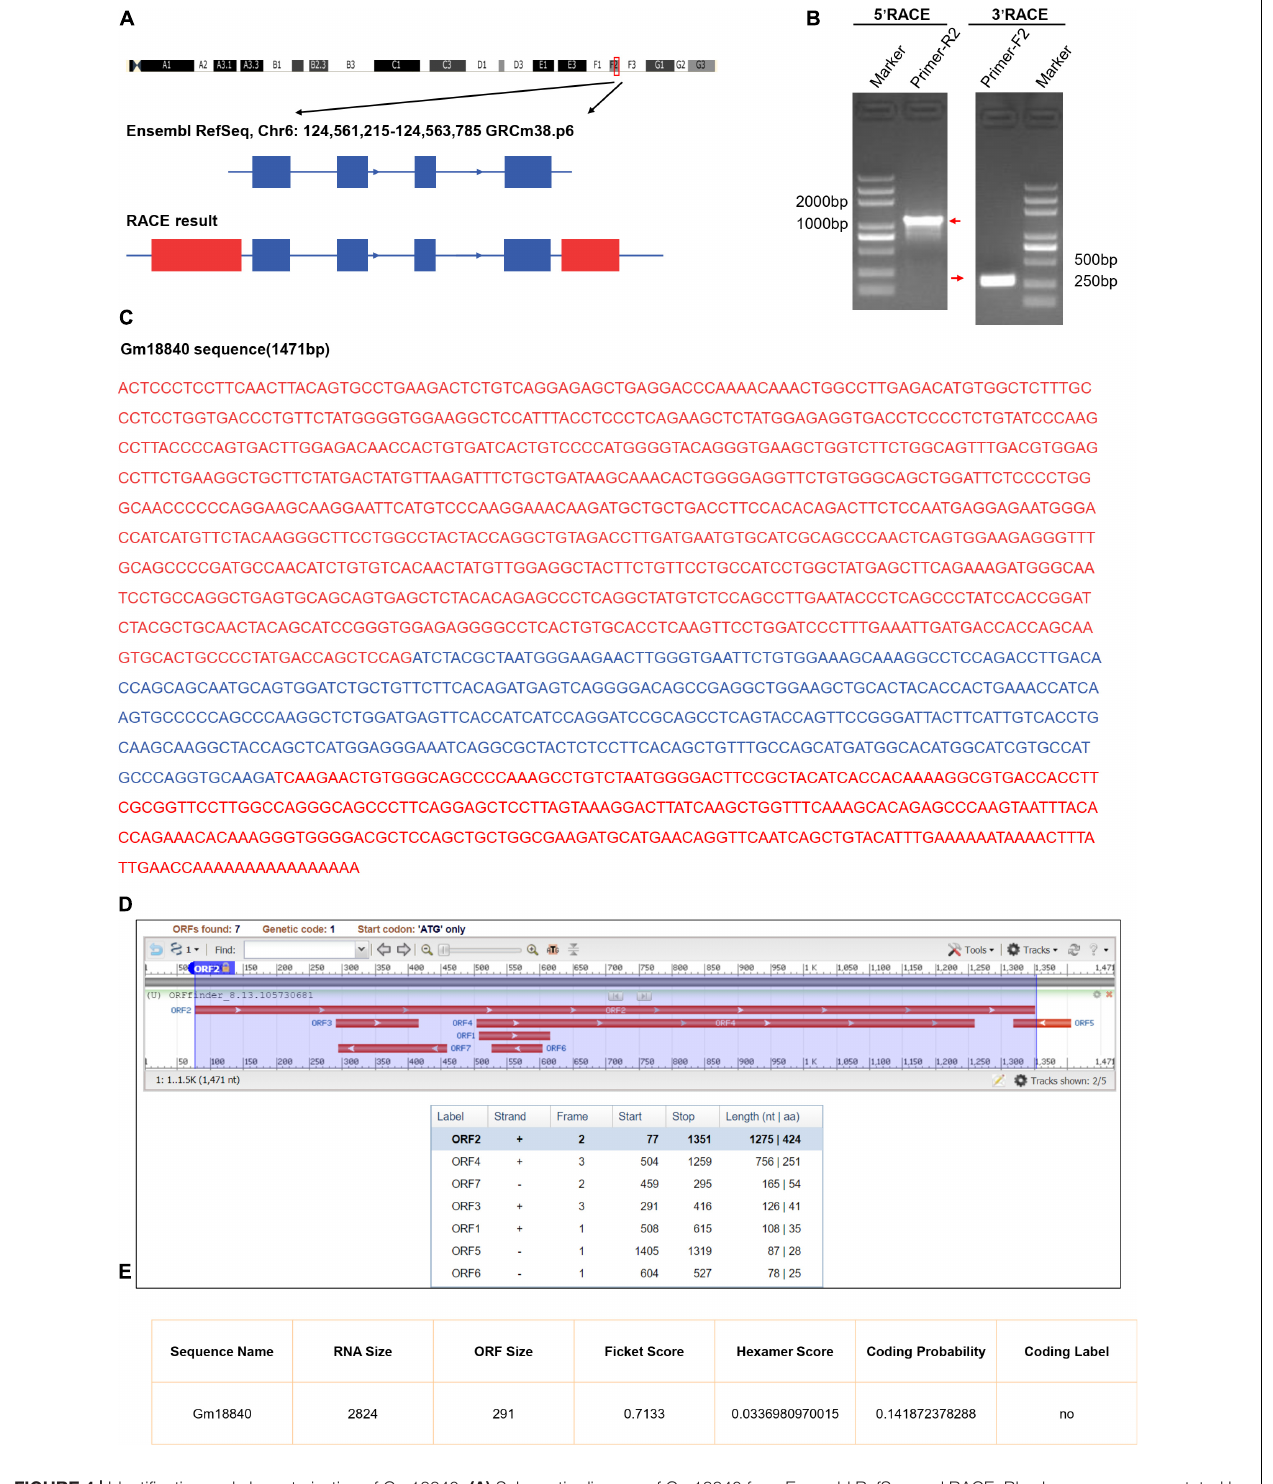
FIGURE 4 | Identification and characterization of Gm18840. (A) Schematic diagram of Gm18840 from Ensembl RefSeq and RACE. Blue boxes: exons annotated by NCBI RefSeq. Red boxes: additional sequences and exons determined by RACE. Blue lines: introns. Arrows on blue lines indicate transcriptional directions. (B) Gel electrophoresis of nested PCR products from 5 (cid:48) -RACE and 3 (cid:48) -RACE. Red arrows indicate product bands. (C) The full-length sequence of the Gm18840 transcript. Blue: reference sequence from NCBI RefSeq. Red: sequence from RACE. (D,E) ORF finder software (D) and CPAT software. (E) Prediction of the protein-coding potential of